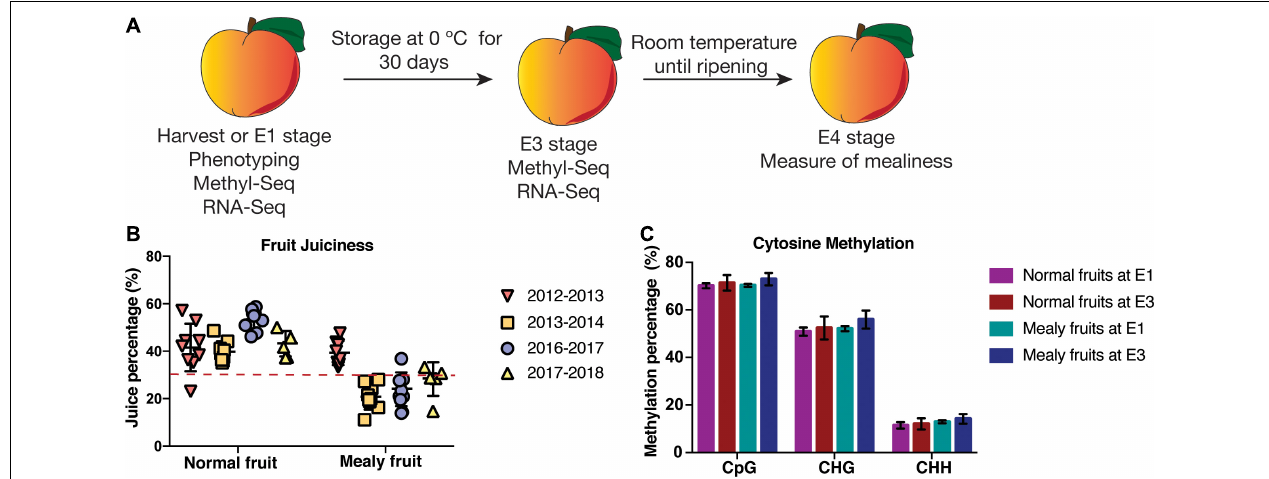
FIGURE 1 | Phenotyping and global levels of DNA methylation in P. persica fruits susceptible and resistant to mealiness. (A) Experimental design for one resistant and one susceptible individual for mealiness. At harvest (E1), three fruits per tree were used for MethylC-Seq and RNA-Seq analysis, while another pool of fruits was stored in a cold chamber at 0 ◦ C to promote mealiness. After 30 days of cold treatment (E3 stage), three fruits were used for MethylC-Seq and RNA-Seq analysis. At E4 stage, at least five fruits were ripened at room temperature and used for the measure of juice content. (B) Juice content (%) during four seasons in at least five fruits of an individual resistant and susceptible to mealiness, respectively. The dotted line represents a 30% threshold to consider fruits as mealy or normal. The same trees were evaluated in all seasons. (C) Absolute methylation levels (%) for cytosine contexts CpG, CHG and CHH (H = C, T or A) in normal and mealy fruits at E1 and